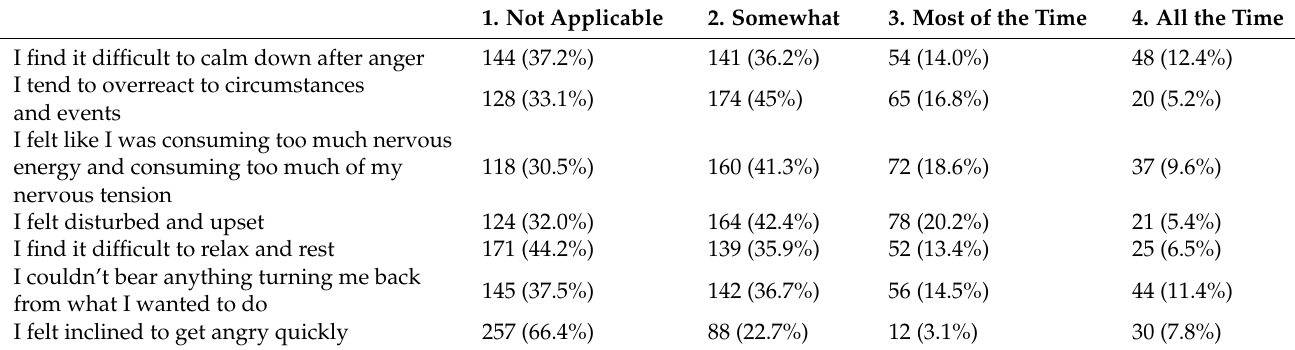
Table 3. Stress indicators of the Saudi day traders.